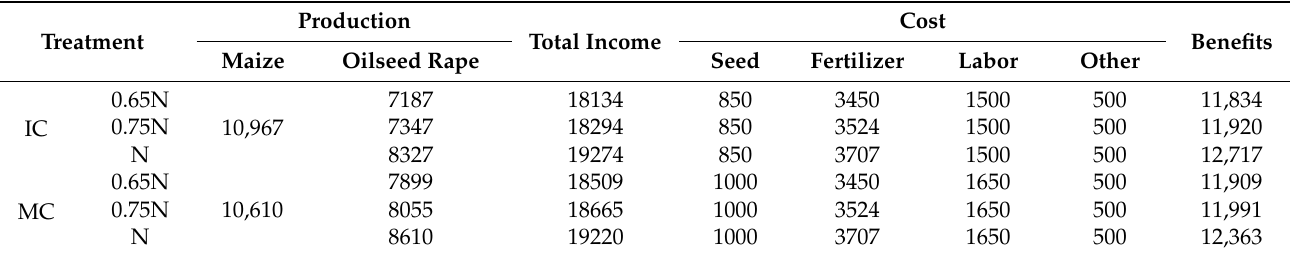
Table 8. Analysis of benefits (CNY ha − 1